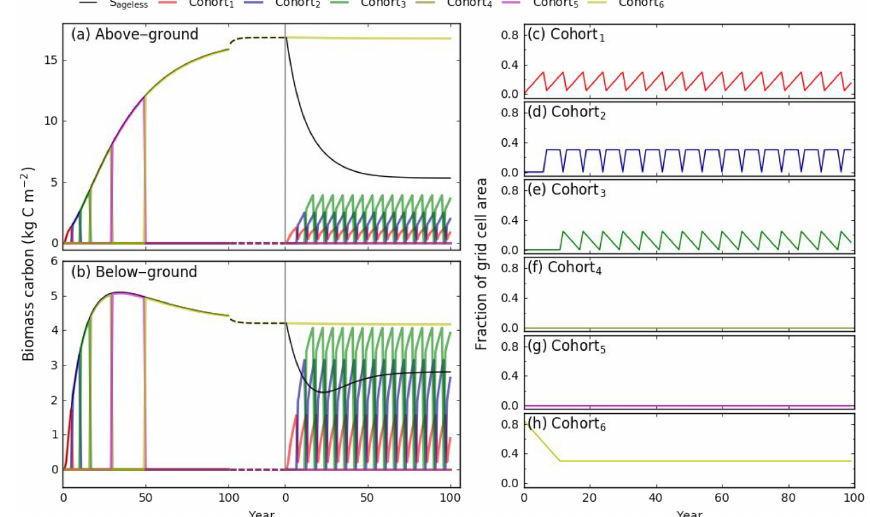
Figure 6. Biomass carbon stock as simulated by two model configurations without ( S ageless ) and with sub-grid age dynamics ( S age , comprised of Cohort 1 to Cohort 6 ) for (a) above-ground biomass and (b) below-ground biomass. Data shown are the biomass accumulation during the spin-up simulation (which lasts for 450 years, from year 0 until the end of the dashed line) and transient simulation (which lasts for 100 years) in which an annual forest–cropland turnover with 5% of the grid cell area is applied. Forest clearing for cropland primarily targets Cohort 3 . Vertical grey lines indicate the end of the spin-up and the start of transient simulations. Panels (c) – (h) show ground coverage by different forest cohorts as fractions of grid cell during the transient simulation